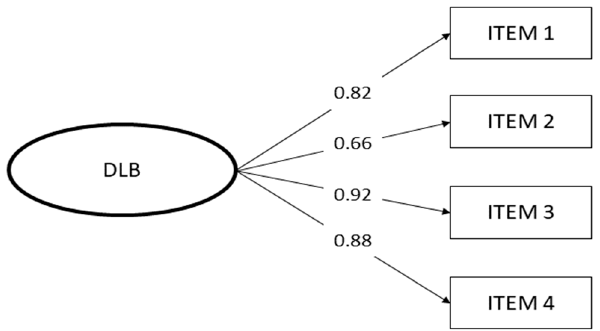
Figure 1. Results of confirmatory factor analysis of the DLB Scale.